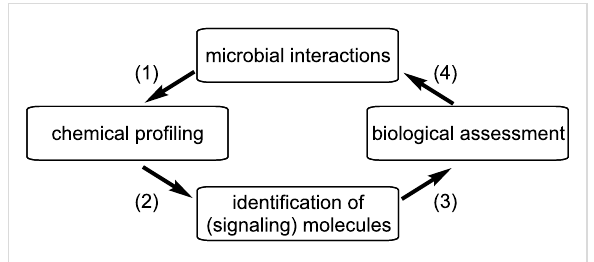
Figure 1: Flow chart of the typical characterization of chemical signals from microbial interactions. (1) Chemical profiling of microbial interac- tions using analytical techniques. (2) Dereplication leads to potentially new small molecules. (3) Optimization of the isolation protocol based on biological assessment of the activity of the isolated compounds. (4) General conclusions about ecological role and evolution of interac- tions.